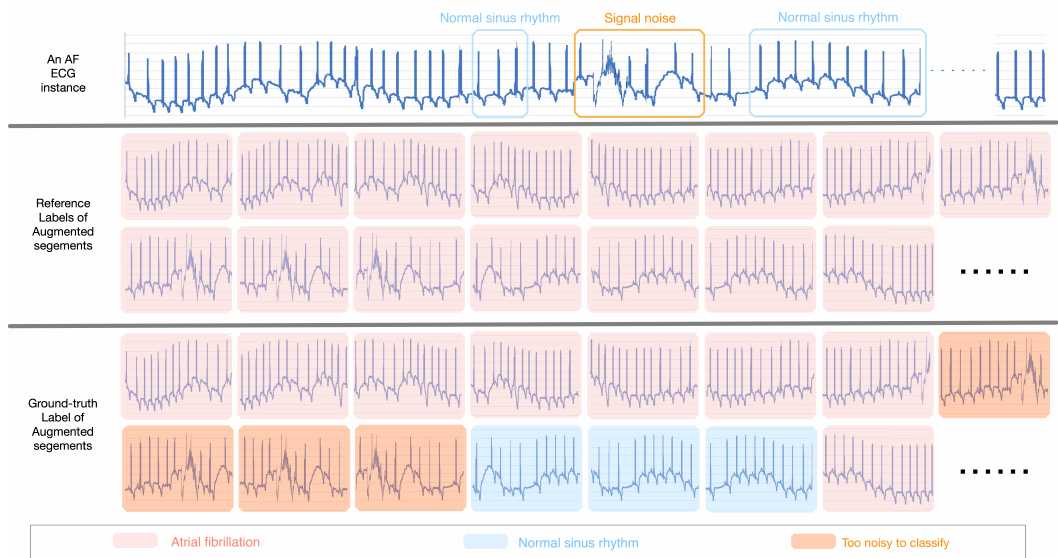
Figure 4. An example of “hard” segments with noisy labels caused by the data augmentation